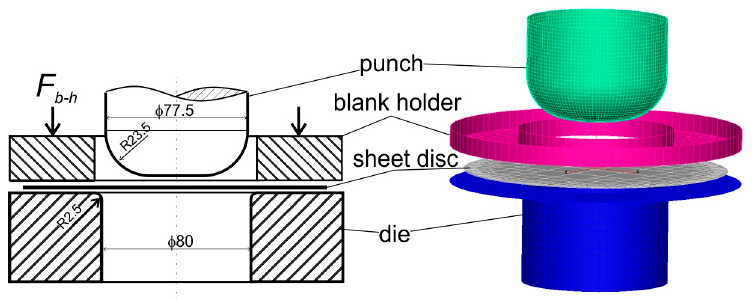
Figure 10. Model of the forming process of the hat-shaped part.